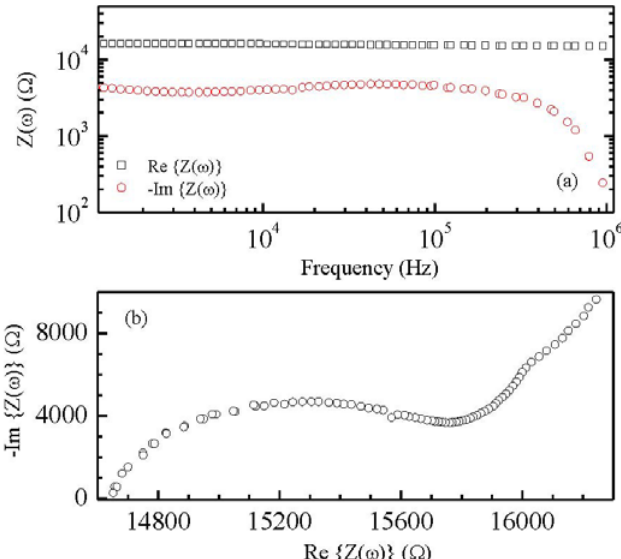
Figure 4. ( a ) Frequency dependence of the complex impedance of a typical Nafion:polypyrrole film; ( b ) Cole Cole plot reporting the opposite of the imaginary part of the impedance versus the real part.